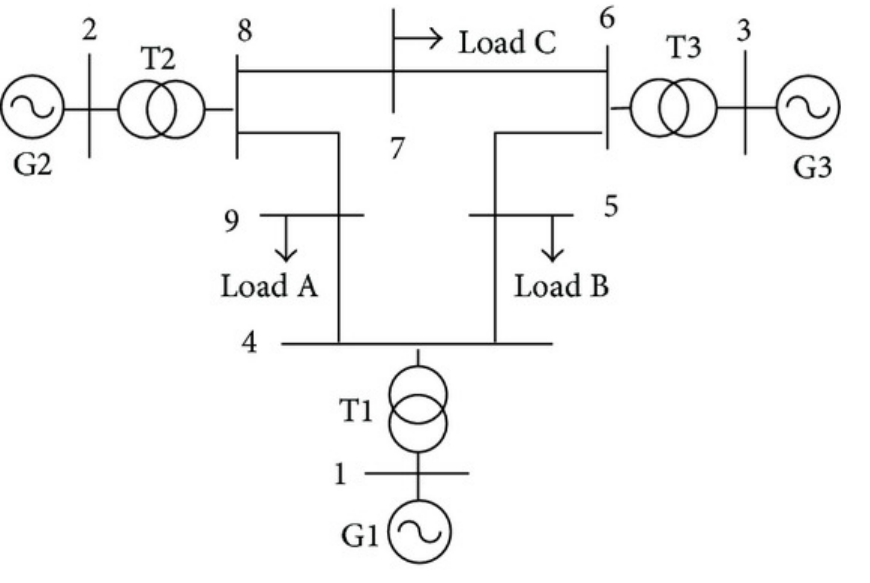
Figure 3. WSCC nine-bus test case system.